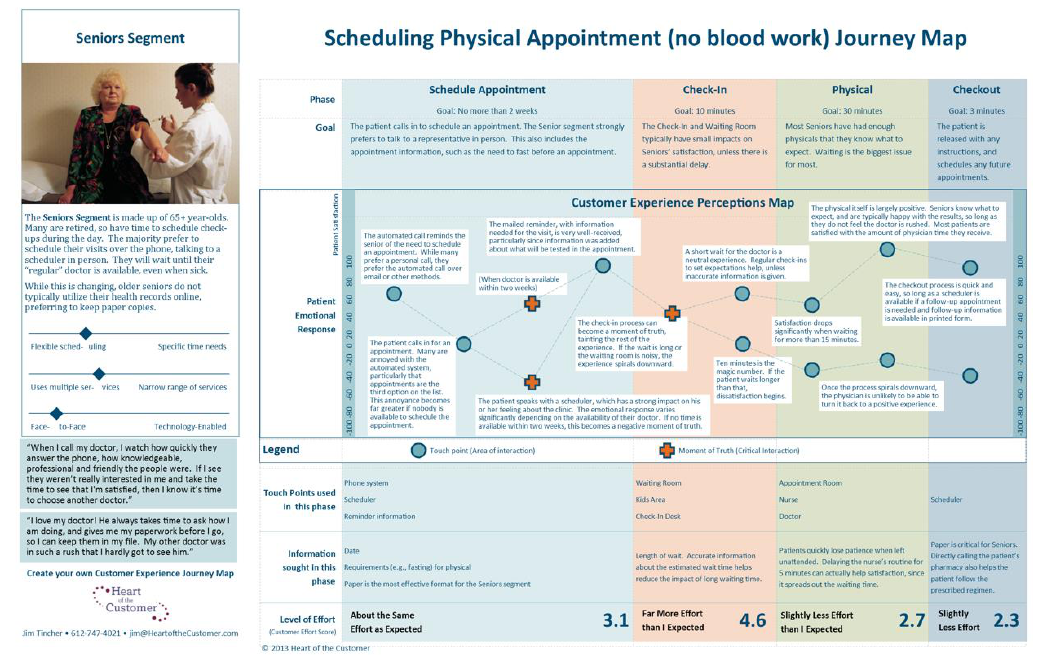
Figure 2. CJM presenting the satisfaction level for each User experience touchpoint [30].